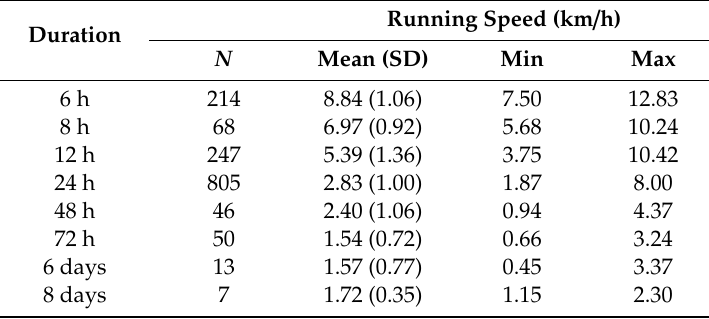
Table 1. Ultra-endurance performance—speed km / h by duration. Mean (SD) and minimum (Min), maximum (Max) were